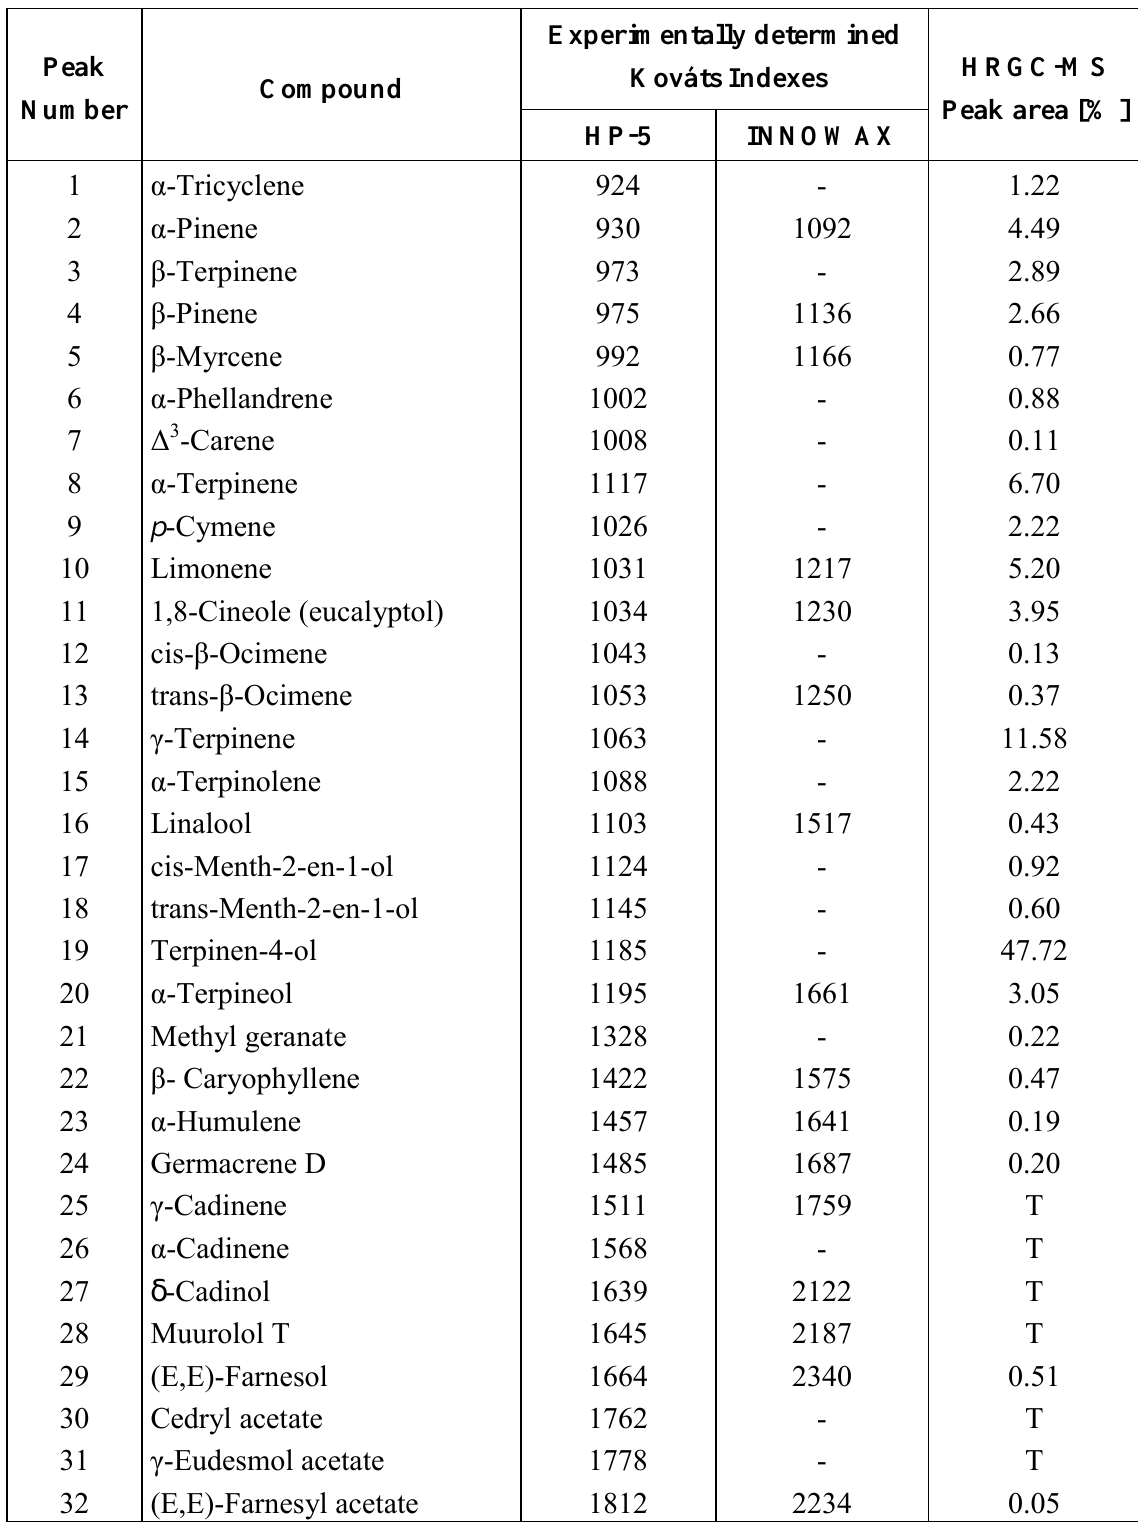
Table 1. Chemical Composition of Colombian Psidium caudatum McVaugh oil extracted from the fresh